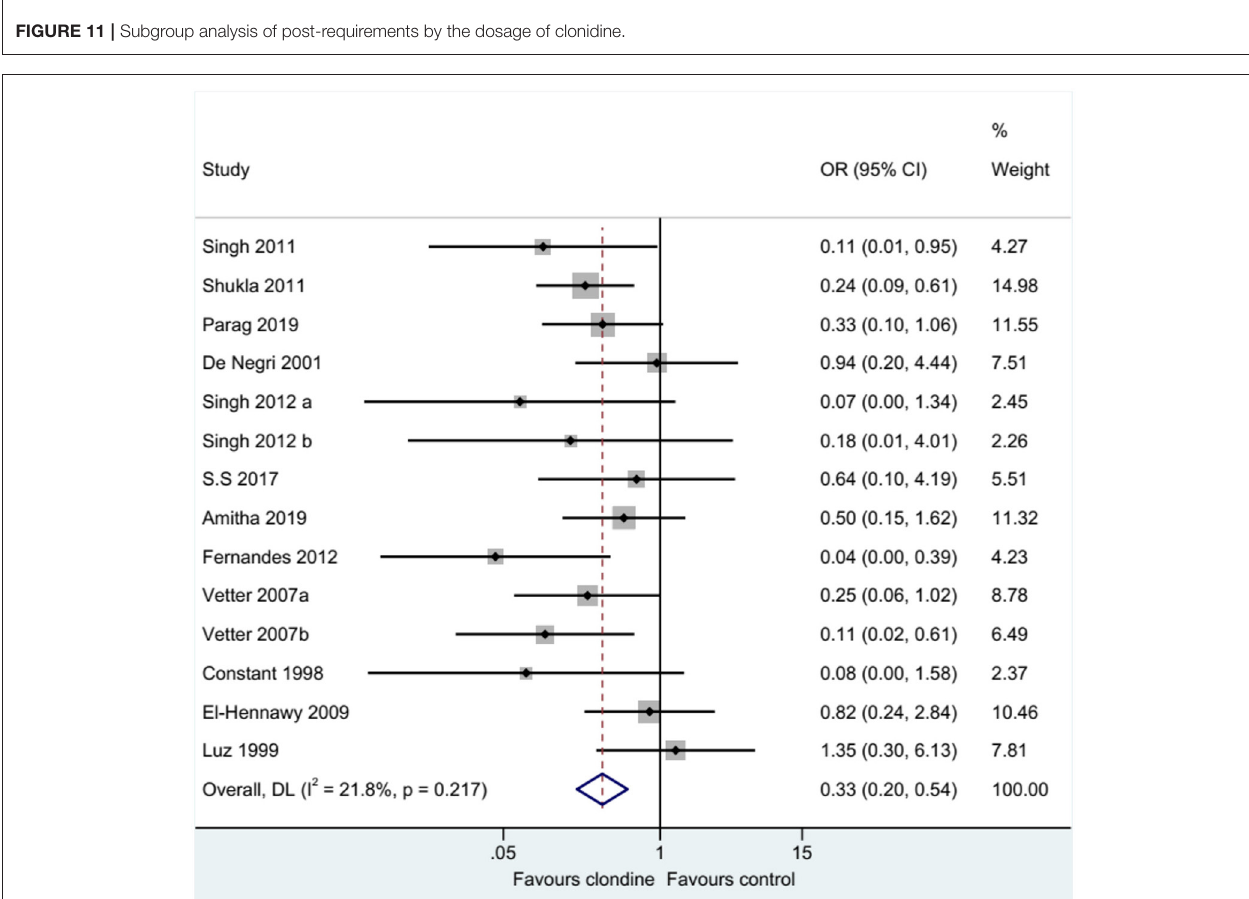
FIGURE 11 | Subgroup analysis of post-requirements by the dosage of clonidine.